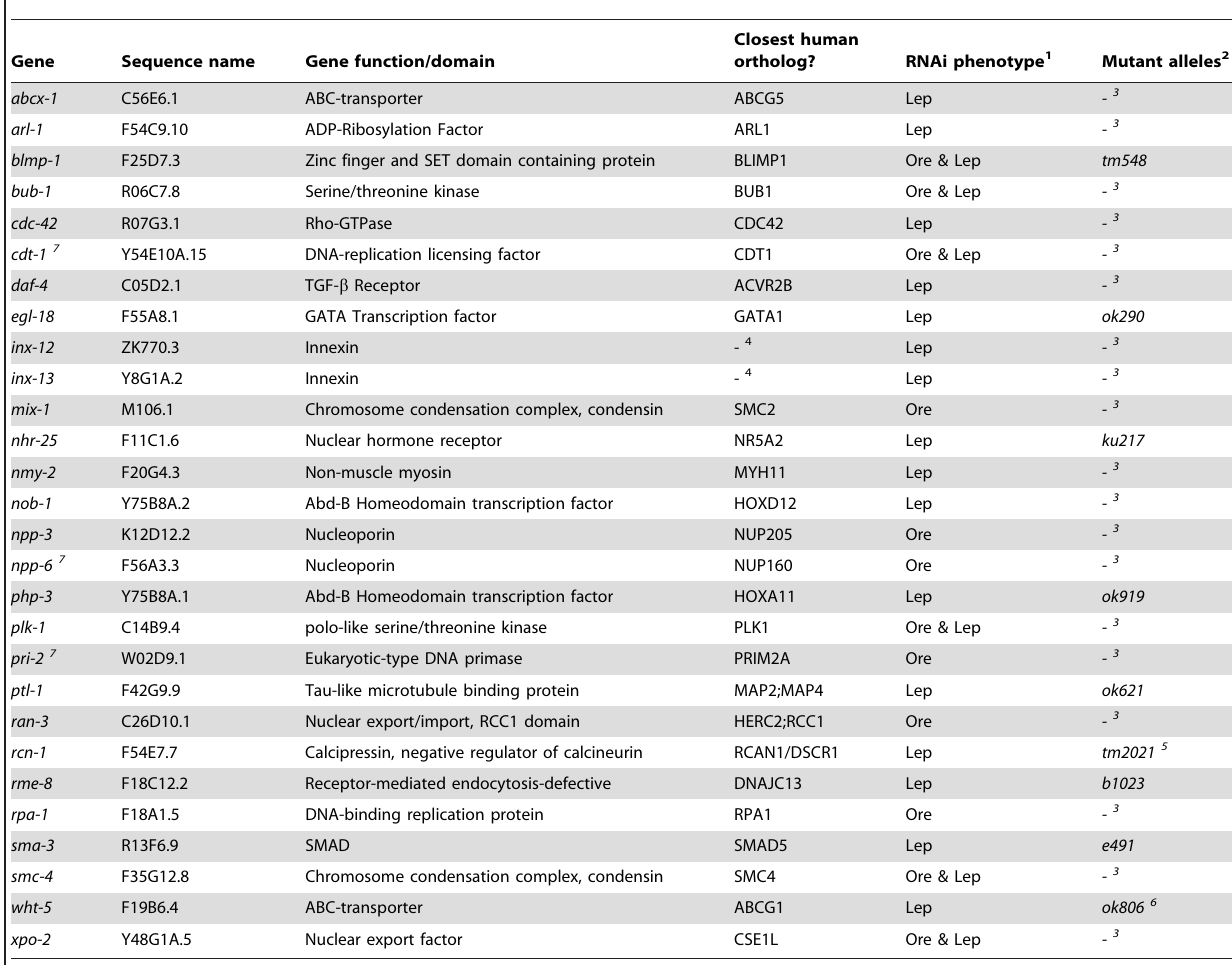
Table 1. Genes identified in the RNAi screen that caused the most severe and/or penetrant tail tip morphogenesis defects.